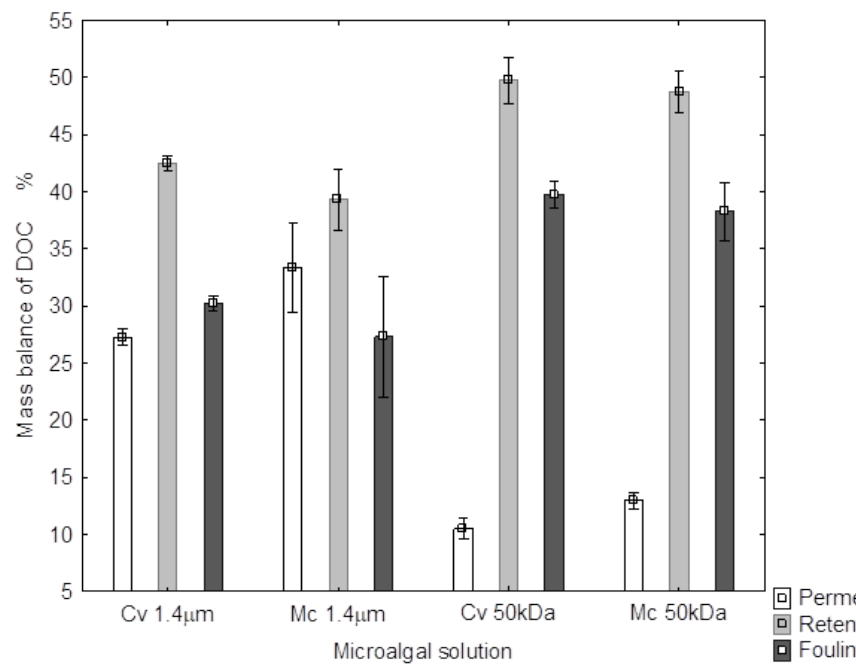
Figure 6. Effects of pore size of membranes on the mass balance of dissolved organic carbon during MF (1.4 µ m) and UF (50 kDa) of the microalgal solution (Cv– C.vulgaris ; Mc– M. contortum ). The error bar indicates the standard error of triplicate measurements.